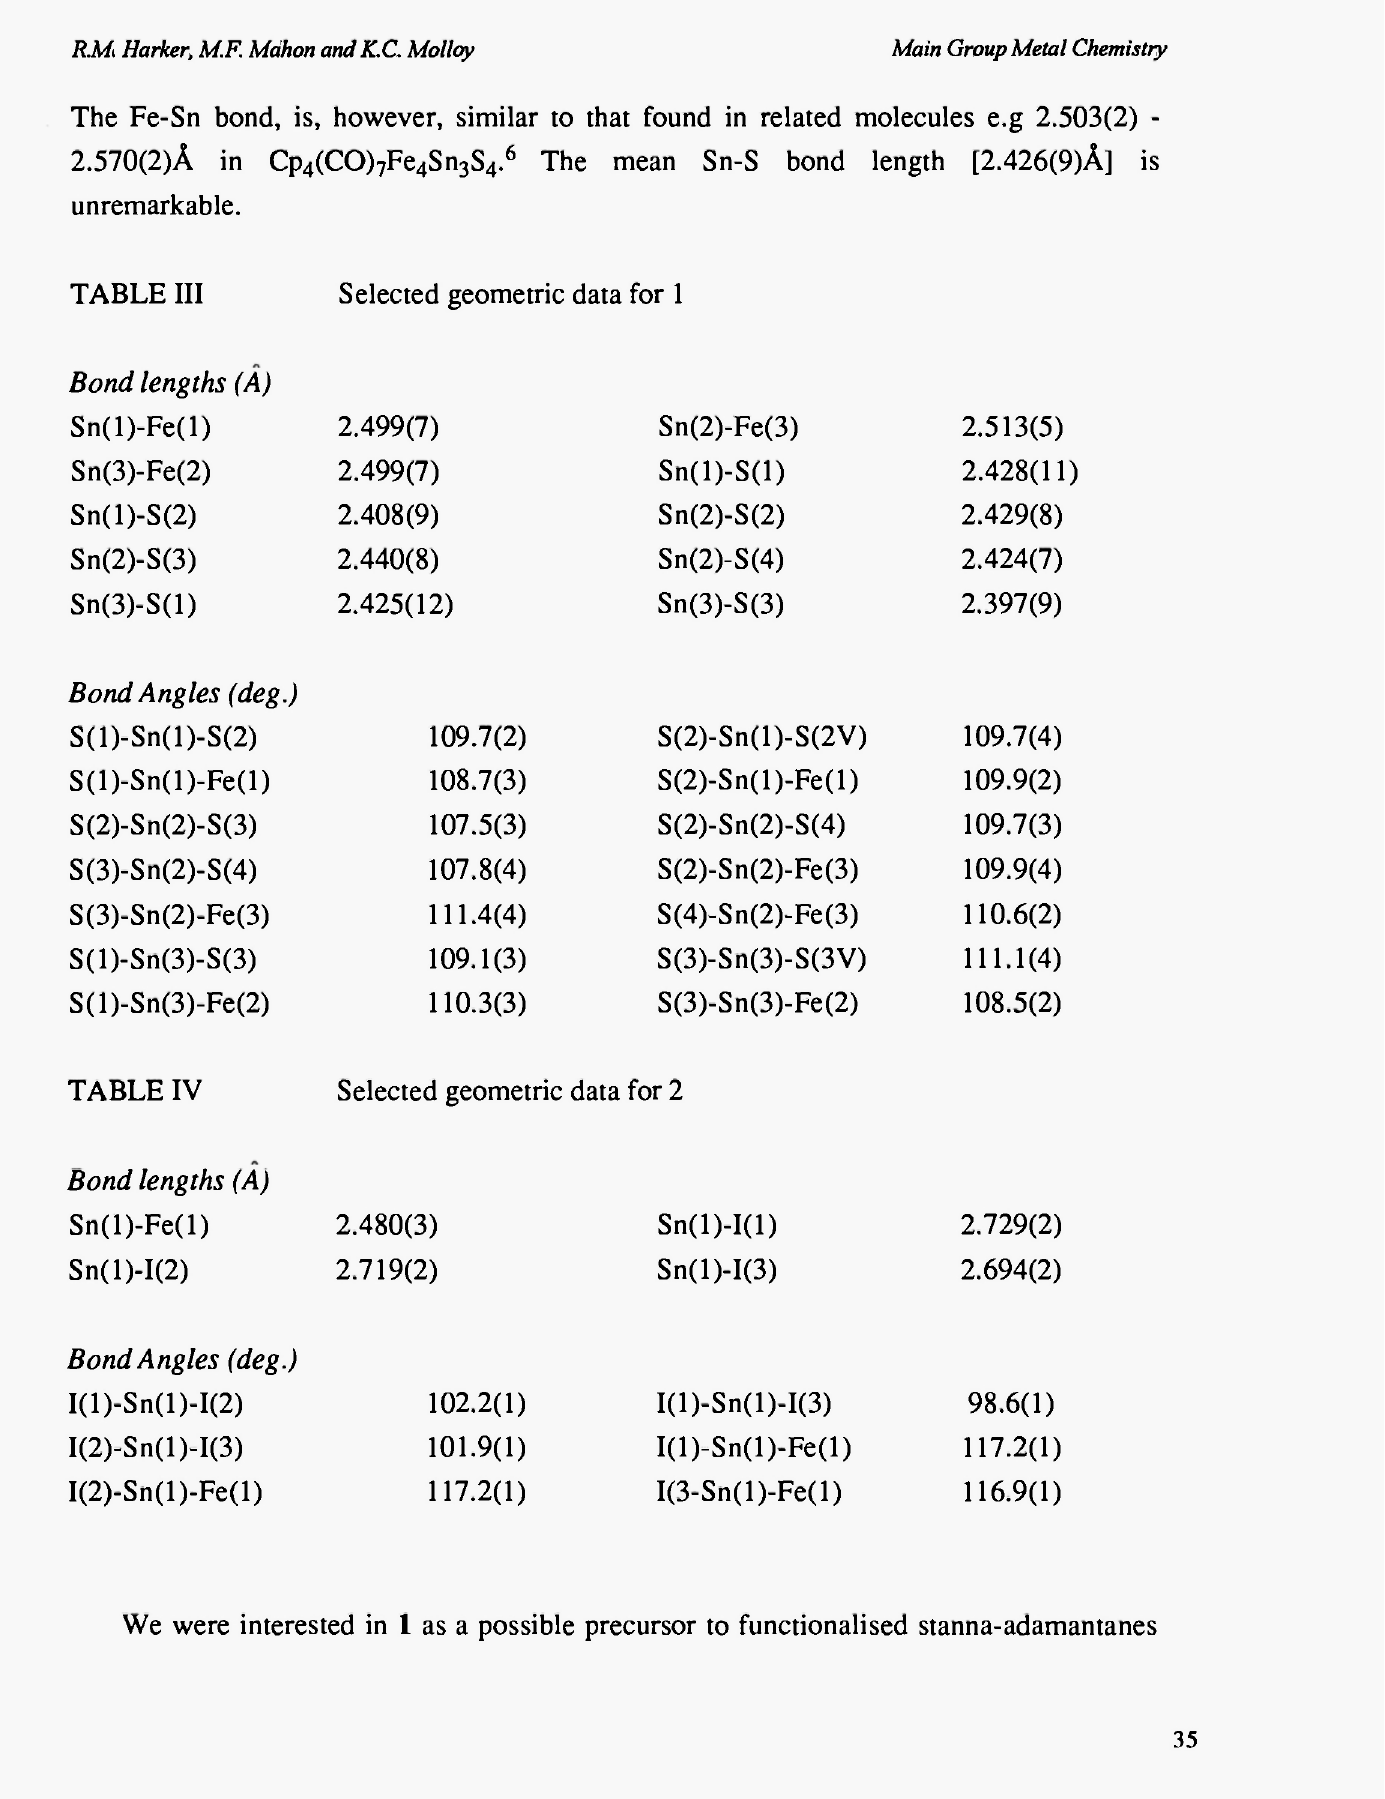
Bond Angles (deg.)